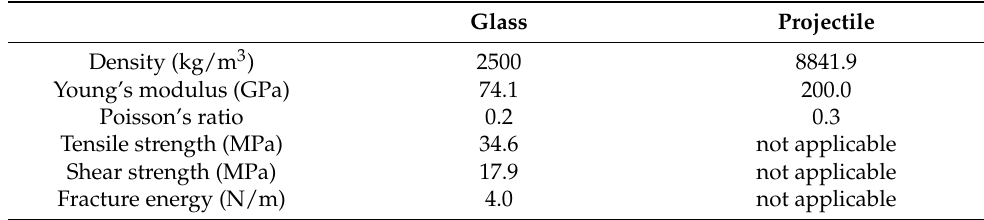
Table 1. Material properties used in the FDEM analysis.